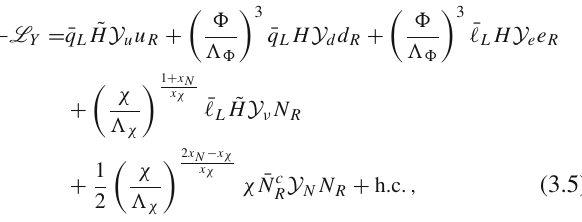
Fig. 1 M σ vs. g parameter space, fixing v = 246 GeV, M h = 125 GeV and taking three values for LN breaking scale, v χ = { 50 GeV , 100 GeV , 2 TeV } . The white area is the one allowed by the bound in Eq. (2.28), while the green region is the excluded one. The dashed line correspond to the bound in Eq. (4.13), being the area above such line